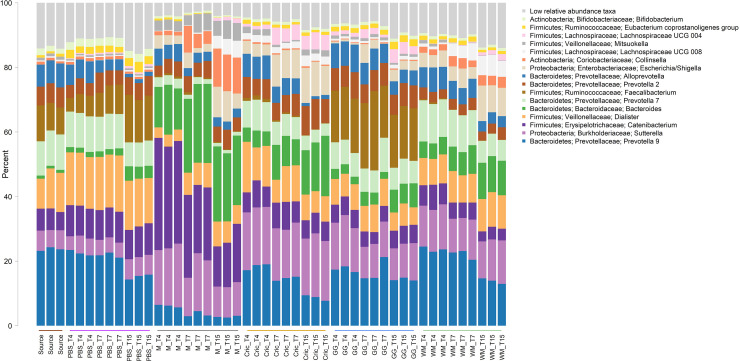
Stacked bar plot of culture community taxonomic composition of taxa at the genus level with mean relative abundance >1%. Individual culture replicates are shown. “Source” indicates starting inoculum, “PBS” indicates control cultures without added substrates, “M” indicates cultures with digested milk, “Cric” indicates cultures with digested black field cricket, “GG” represent cultures with digested grass grub, and “WM” represents cultures with digested wax moth. “T4”, T7”, and “T15” indicate 4, 7, and 15 h culture times, respectively. Low relative abundance taxa indicate sum of taxa with relative abundances <1%. Color sidebar along X-axis differentiate different substrates.